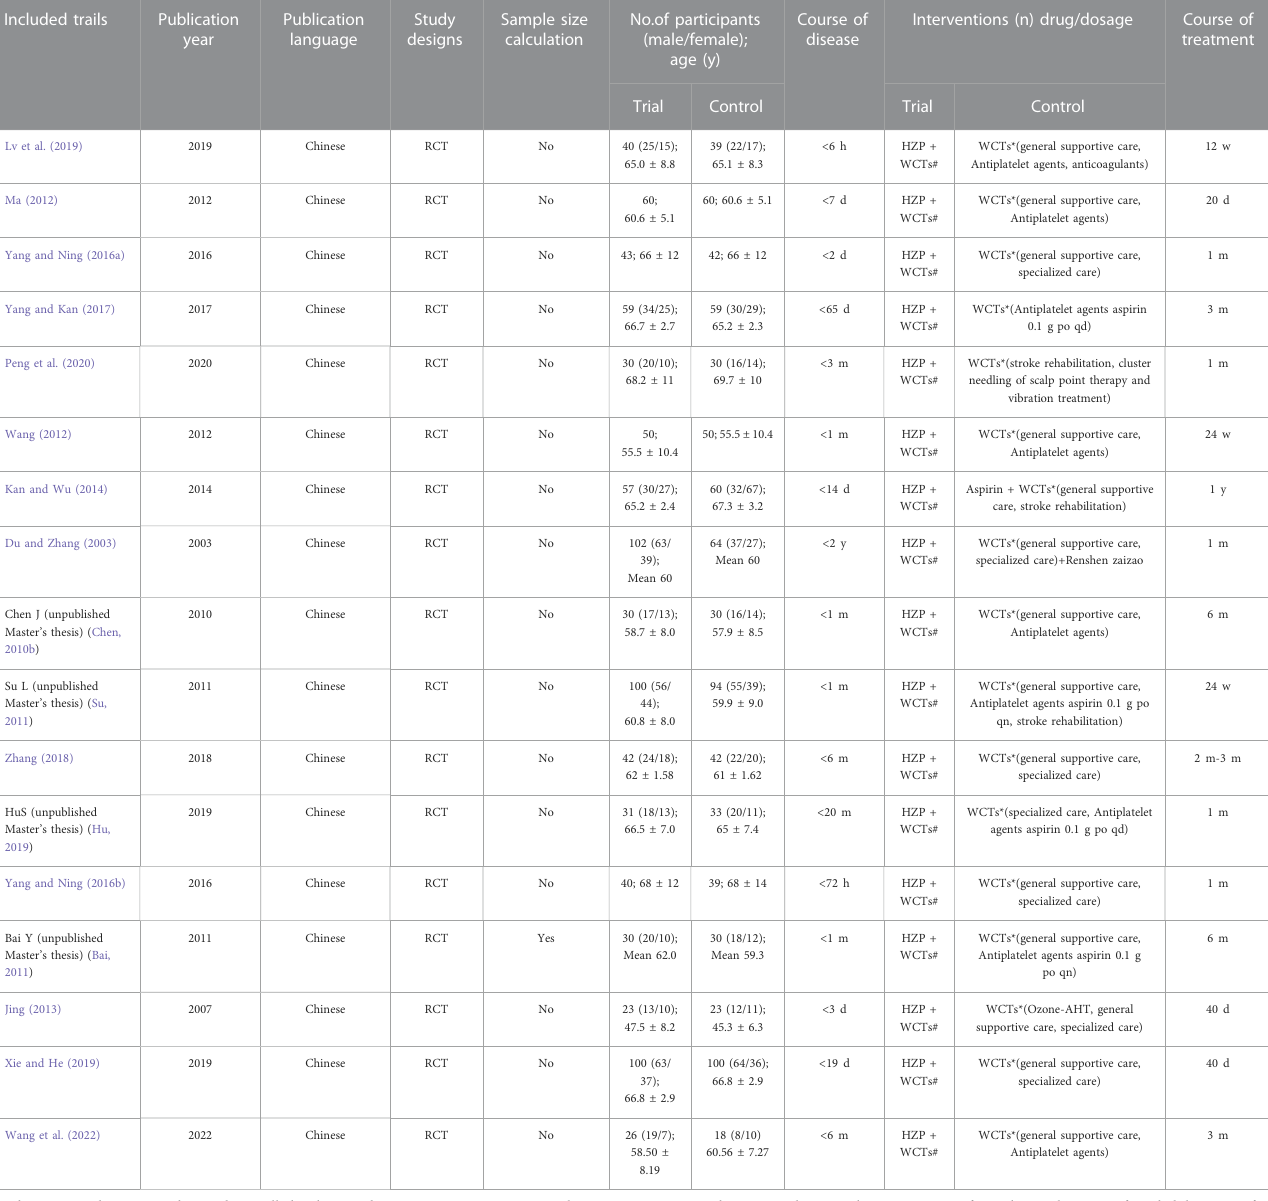
TABLE 1 The characteristics of the included 17 studies. Included